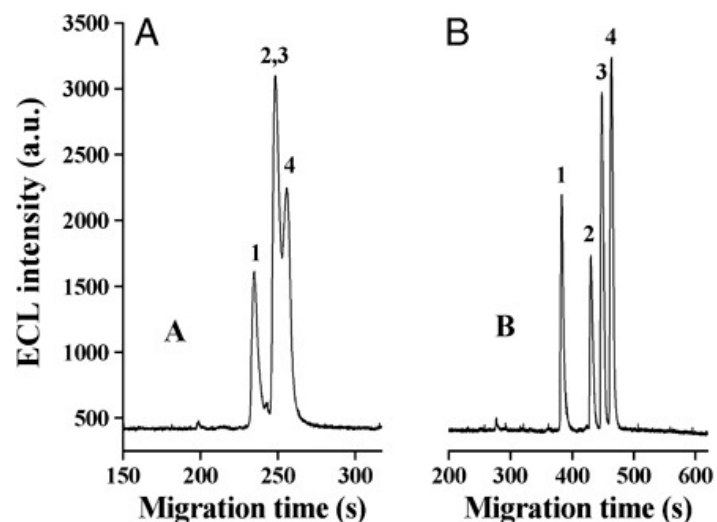
Figure 10. Electropherograms of four standard samples: ( A ) without IL in electrophoretic buffer; ( B ) with the use of 0.6% BIMPF 4 in the electrophoretic buffer. Peak: 1, 10 µmol/L methylephedrine hydrochloride; 2, 40 µmol/L of thebaine; 3, 25 µmol/L codeine phosphate; 4, 15 µmol/L acetylcodeine. Conditions: electrophoretic buffer, 14 mmol/L phosphate–borax at pH 7.4; electrokinetic injection, 10 s × 10 kV; separation voltage, 15 kV; detection potential, 1.2 V; ECL solution, 5 mmol/L Ru(bpy) 32+ with 50 mmol/L PBS at pH 8.2. Figure adopted from [216] with permission.